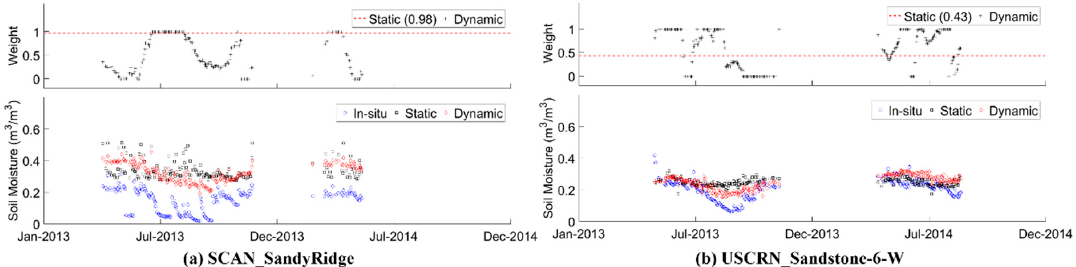
Figure 7. Dynamic and static combination results using MERRA-Land as the reference at ( a ) Sandy Ridge station in Soil Climate Analysis Network and ( b ) Sandstone-6-W station in U.S. Climate Reference Network. Each panel shows static/dynamic weights ( top ), as well as time series of statically- and dynamically-combined soil moisture products ( bottom ).